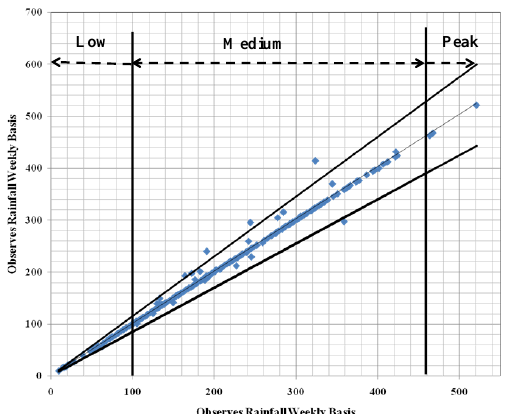
Figure 16 Forecasted and actual Rainfall on Klang River (weekly Fig. 16. Forecasted and actual rainfall at Klang River (weekly ba-